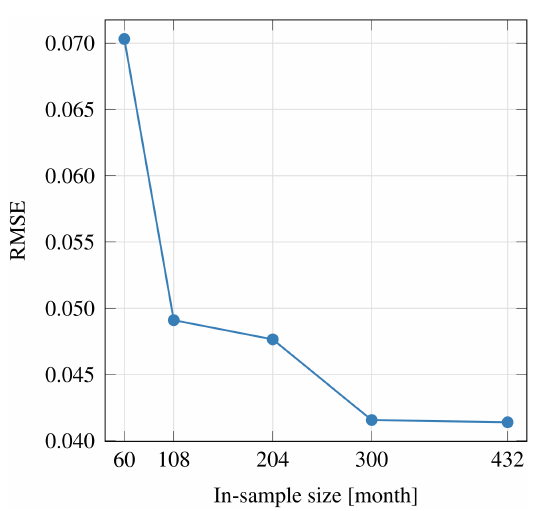
Figure 13. Convergence study of in-sample